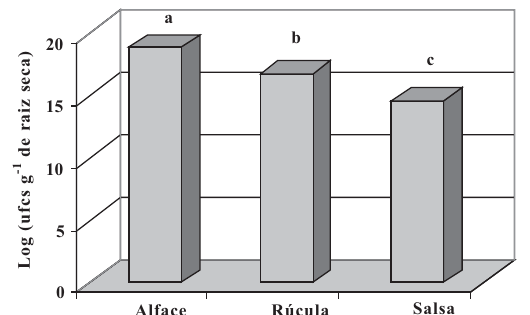
Figura 1. Número de Pseudomonas spp. fluorescen- tes na rizosfera de alface, rúcula e salsa, em qua- tro locais: Matão, Boa Esperança, São Gonçalo e Santa Genebra. Média de 10 repetições; coefici- ente de variação = 9,63 %. Colunas seguidas de letras diferentes diferem entre si a 5 % pelo teste de Tukey. ufcs: unidades formadoras de colôni-